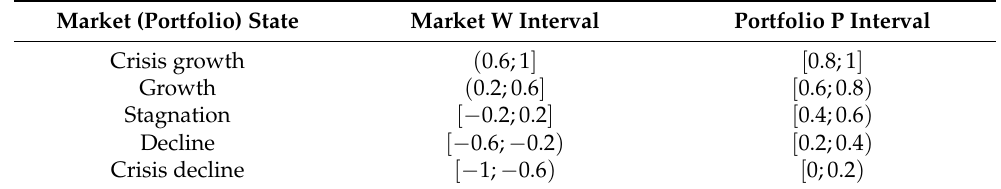
Table 3. Normalized scale of market states and portfolio states.